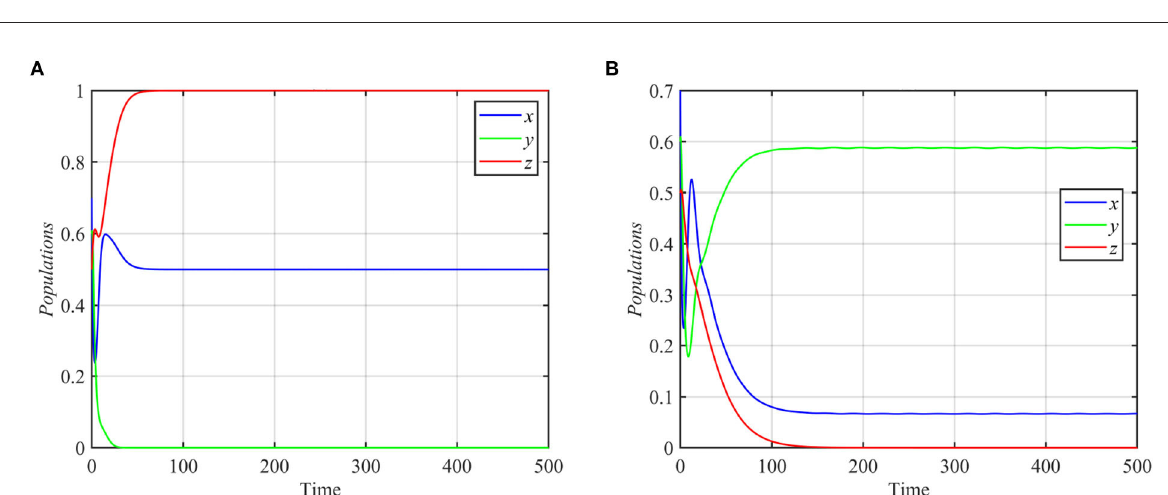
(0.03,0.39,0). (B) Time series for trajectories of x , y , and z for a 1 =